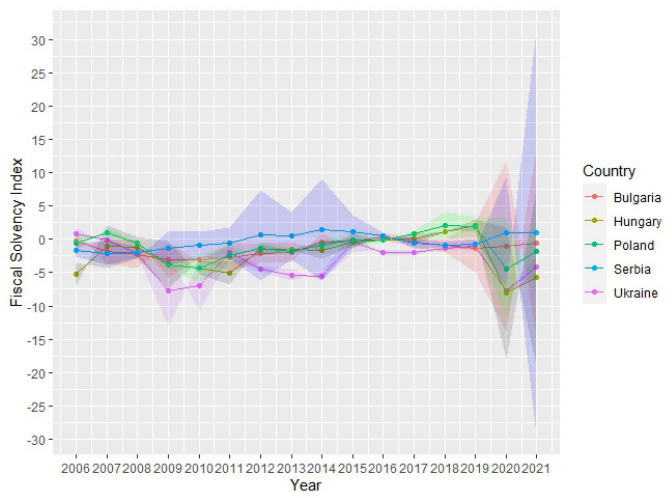
Figure 6. Fitted values of models, Hypothesis 2, with standard error